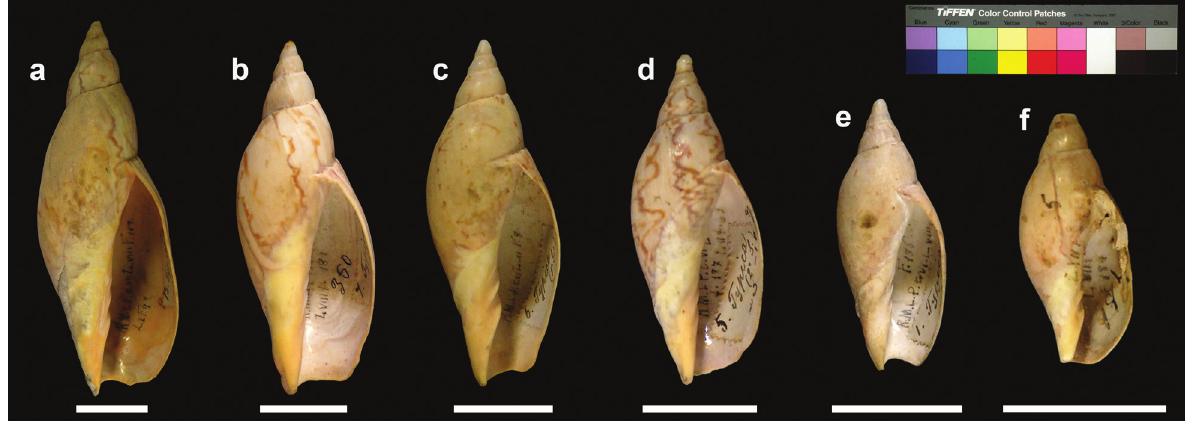
Figure 7. Voluta ancilla typica , specimens figured by Lahille (1895: pls I, II, VIII, XI, XII. See references on Table 2. Scale bars: 3 cm.